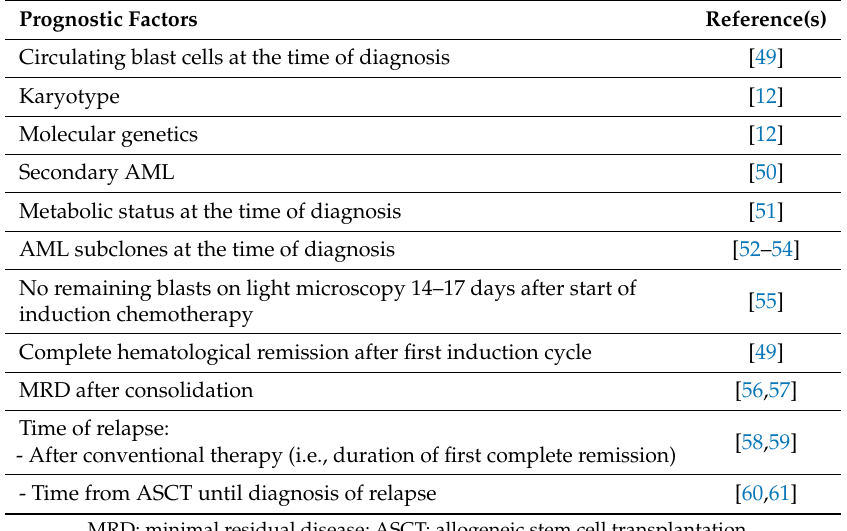
Table 1. The current basis for prognostication of acute myeloid leukemia (AML)